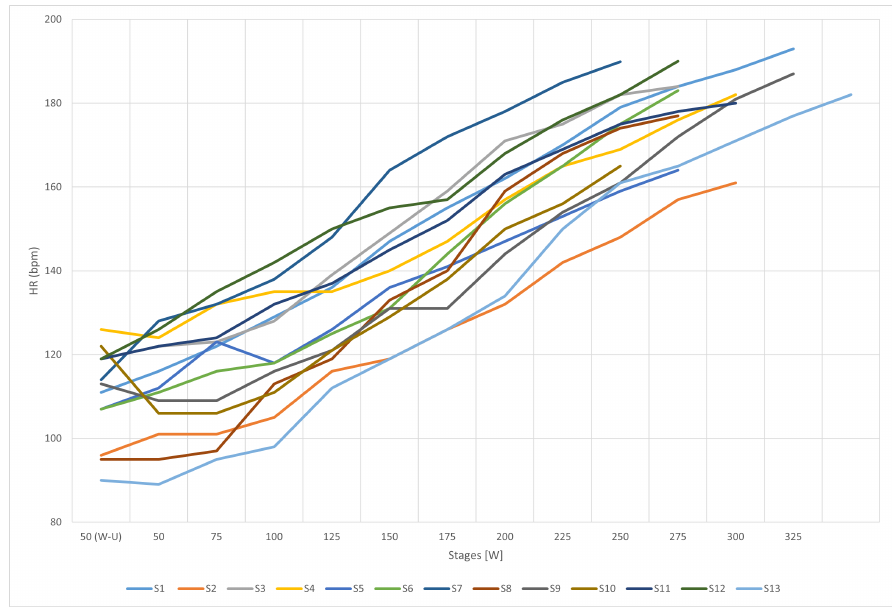
Figure 2. The relationship between heart rate and stages; S1:S13—research subjects.